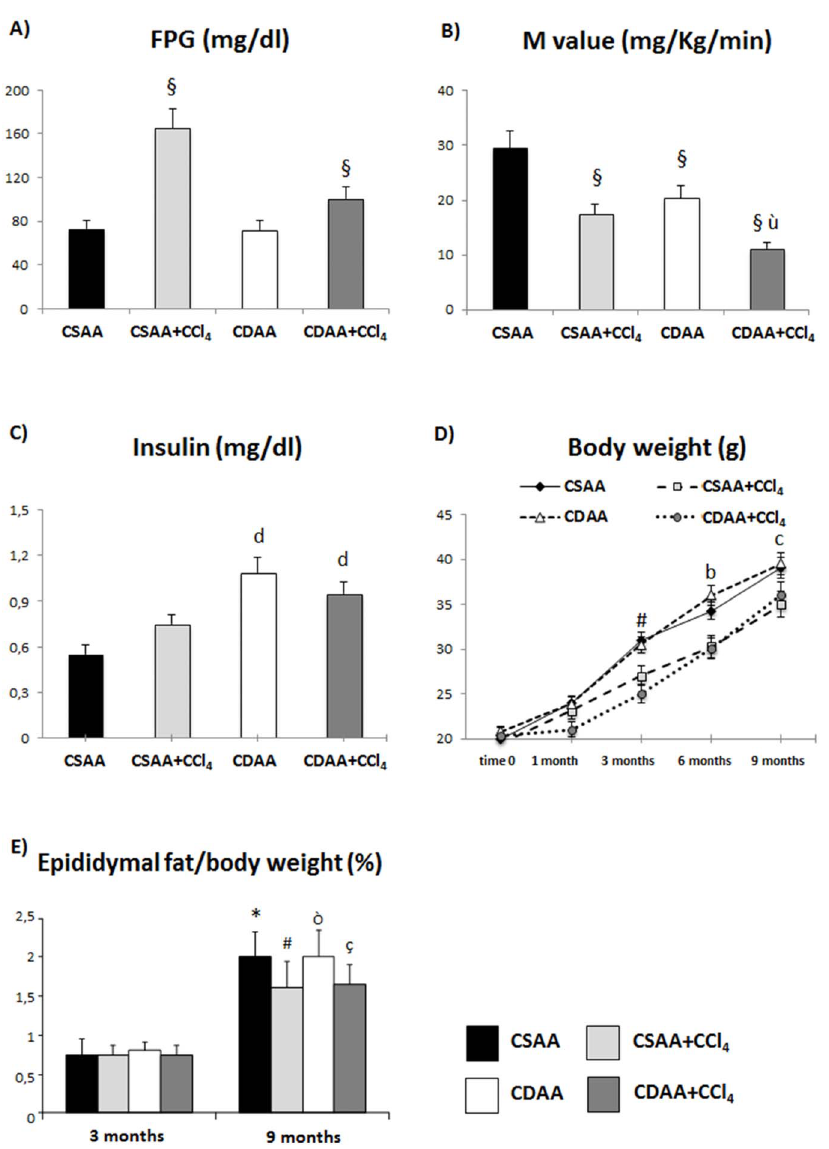
Figure 1. Effect of diet treatment on metabolic parameters and body weight. A–B) Mice treated with CDAA diet for 1 month develop peripheral insulin resistance as shown by the lower glucose uptake vs CSAA-treated mice (M value) with similar levels of FPG. CCl 4 treatment induces an increase in fasting plasma glucose and enhances the condition of insulin resistance, reducing M value. C) Insulin levels measured at 1 month of treatment. D) The graphic shows a gradual increase in body weight in both CDAA and CSAA diet. CCl 4 injection similarly reduces body weight in both diets. E) Epididymal fat/body weight ratio appears to be similar between the two different diets both at 3 and 9 months of treatment, with similar reduction in the presence of CCl 4 . Data represent mean 6 SD; 1 p , 0.05 vs CSAA; u` p , 0.05 vs CDAA; *p , 0.05 vs CSAA 3 months; # p , 0.05 vs CSAA + CCl 4 3 months; o` p , 0.05 vs CDAA 3 months; c¸ p , 0.05 vs CDAA + CCl 4 3 months; b p , 0.05 vs CSAA + CCl 4 6 months; c p , 0.05 vs CSAA + CCl 4 9 months; d p , 0.05 vs